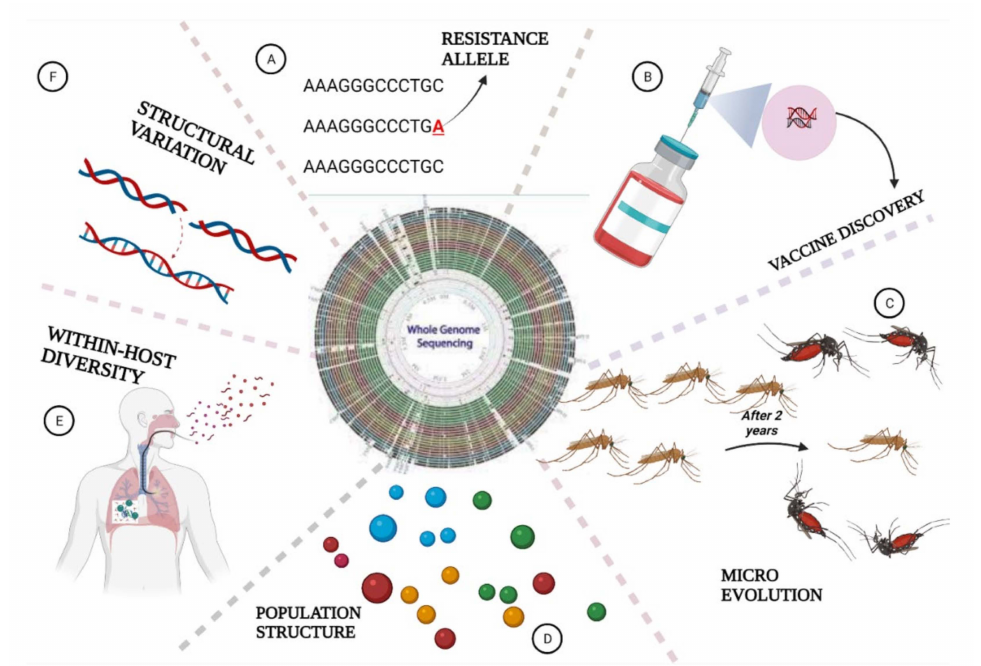
Figure 3. Different roles of WGS in malaria research. ( A ) shows resistance allele (SNP) conferring resistance to antimalarial. ( B ) shows discovery of vaccine candidate genes which may lead to vaccine discovery. ( C ) depicts microevolution from wild to resistant mosquitoes’ population. ( D ) depicts par- asites population structure. ( E ) speaks to diverse mosquito genotypes within an infection. ( F ) shows variation in size of DNA. A part of the DNA has been